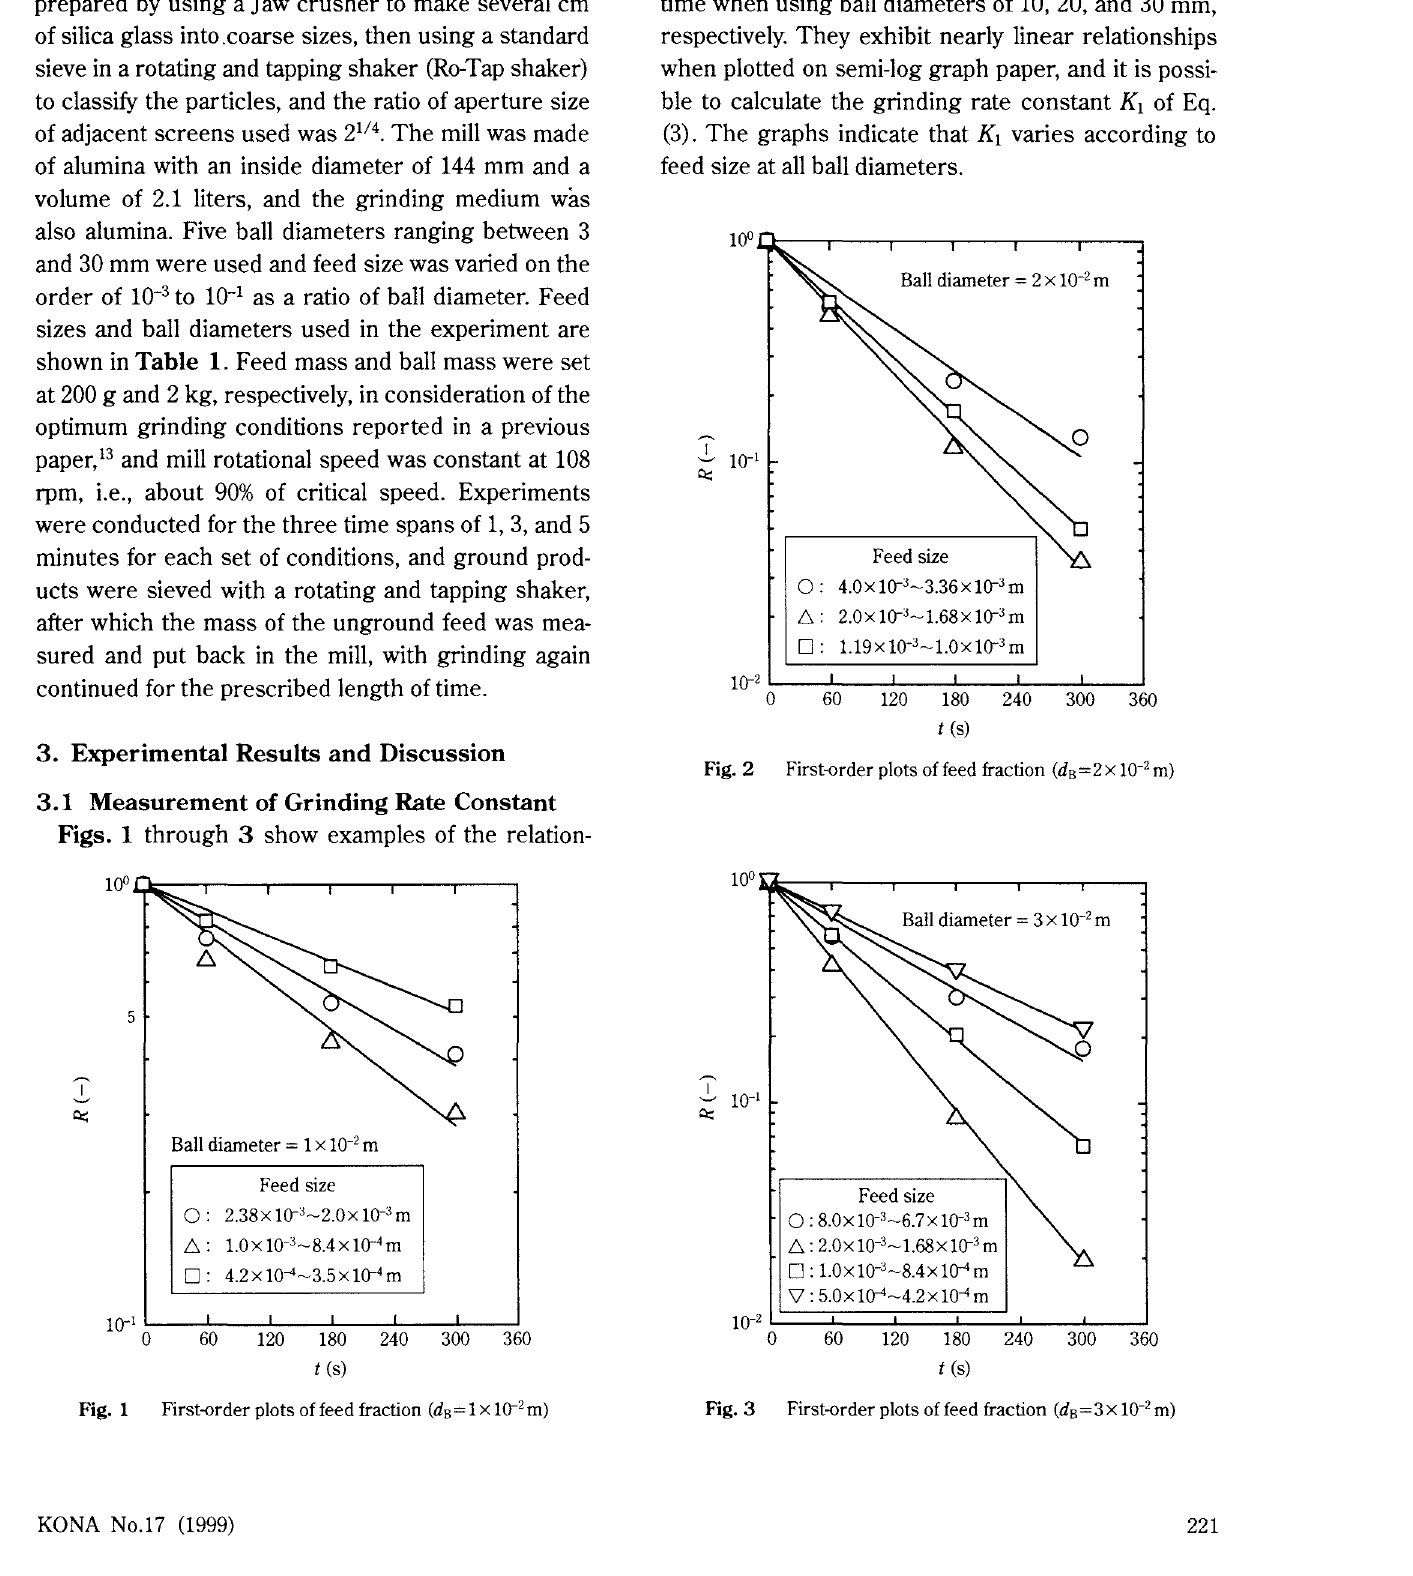
Fig. 1 First-order plots of feed fraction (d 8 = 1 x I0- 2 m) KONA No.17 (1999)